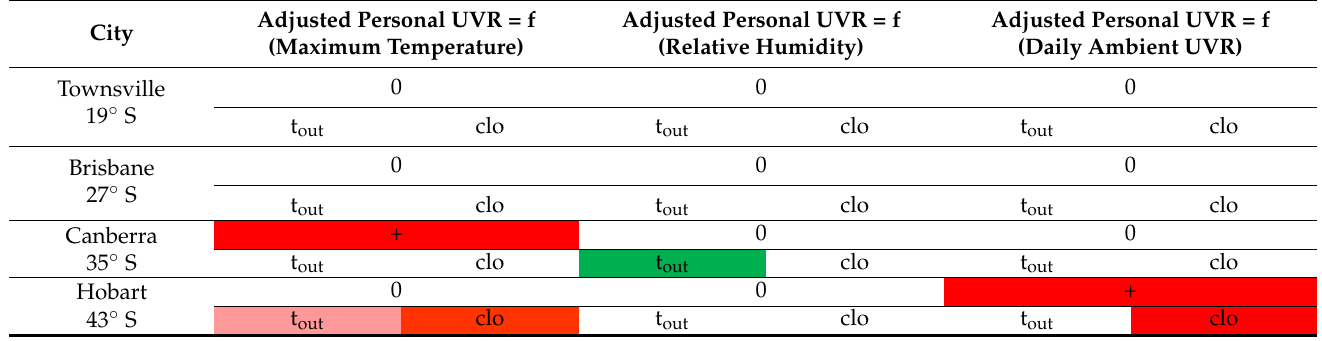
Table 1. Relationship between the individual clothing-adjusted UVR doses and meteorological factors (maximum temperature, relative humidity, ambient UVR) in Australian locations (data base: [32]). Causes of the changes in the individual UVR doses: changes in the time spend outdoors (t out ) or changes in clothing (clo). Color white: no association (0); color red: statistically significant positive association (+); color slightly red: positive, but not statistically significant association; color green: statistically significant negative